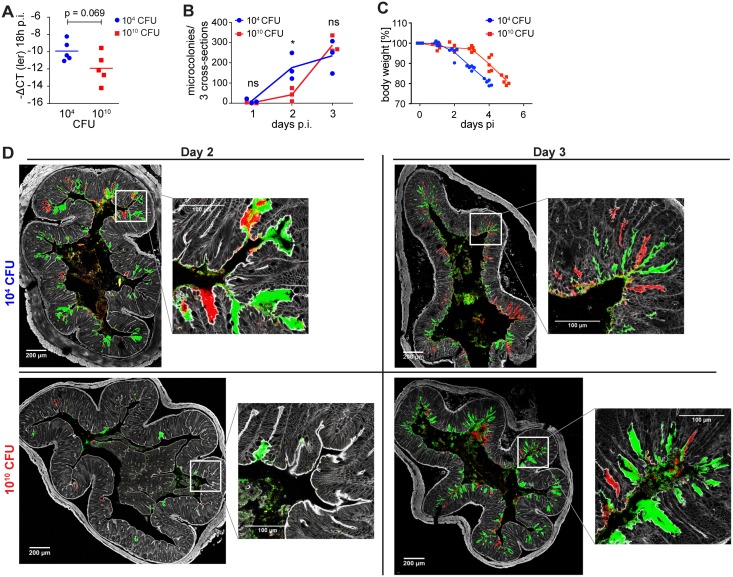
High-dose C. rodentium-infected MyD88/Trif-deficient mice do not display persistent disease attenuation.(A-C) Germ-free MyD88-/-Triflps/lps mice were infected with either a low (104 CFU, blue dots) or a high dose (1010 CFU, red squares) of wild type C. rodentium. (A) qPCR quantification of bacterial ler mRNA in colon content of infected MyD88-/-Triflps/lps germ-free mice at time point 18 h. Expression of ler was normalized to the mRNA encoding bacterial housekeeping gene rpoD. (B) Microcolonies were quantitated in the distal colon after 1, 2, or 3 days of infection. (n = 3 per group, pooled from two independent experiments). (C) Body weights of germ-free MyD88-/-Triflps/lps mice infected with either a low (104 CFU, blue circles) or a high dose (1010 CFU, red squares) of wild type C. rodentium were monitored daily until reaching ethical endpoint. Symbols represent individual mice. (D) Representative fluorescent microscopy images of distal colon of germ-free MyD88-/-Triflps/lps mice after infection with doses of 104 or 1010 CFU of C. rodentium for 2 days (left) and 3 days (right). Every individual depicted was infected with a 1:1 mixture of bacteria carrying a mCherry and GFP expression plasmid, respectively. Grey, F-actin/phalloidin; green, GFP-expressing C. rodentium; red, mCherry-expressing C. rodentium. Scale bars: 200 μm and 100 μm as indicated. ns, statistically not significant; *, p < 0.05; Student`s t-test.